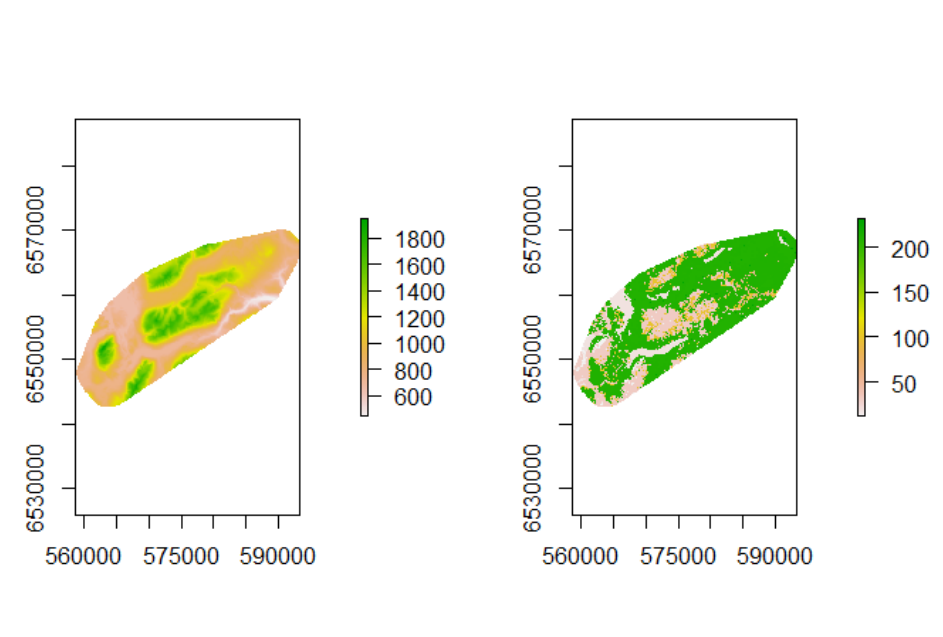
Figure 12: Output of plot(dem) and